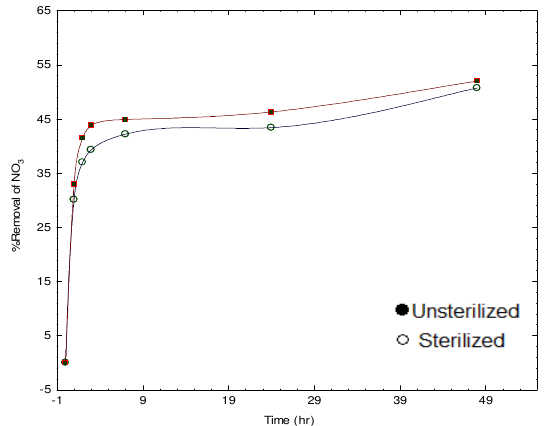
Fig. 11. Effect of sterilization on Removal percent of NO 3 pollutant with time at T = 25 o C, pH 7, wastewater/ (Algae broth) ratio = 1.